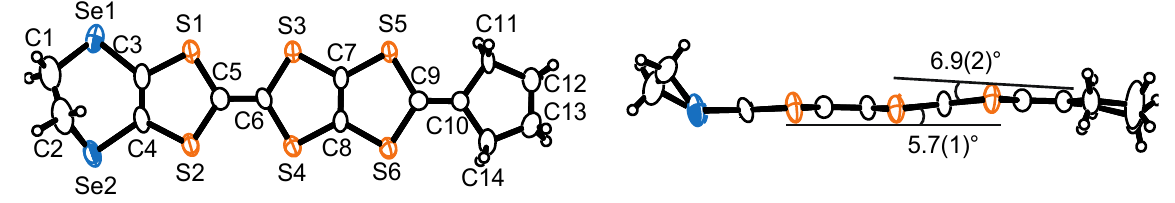
Figure 18. Top view (left) and side view (right) of ORTEP drawings for the CPDTES molecule in 7 . Displacement ellipsoids are drawn at the 50% probability level.